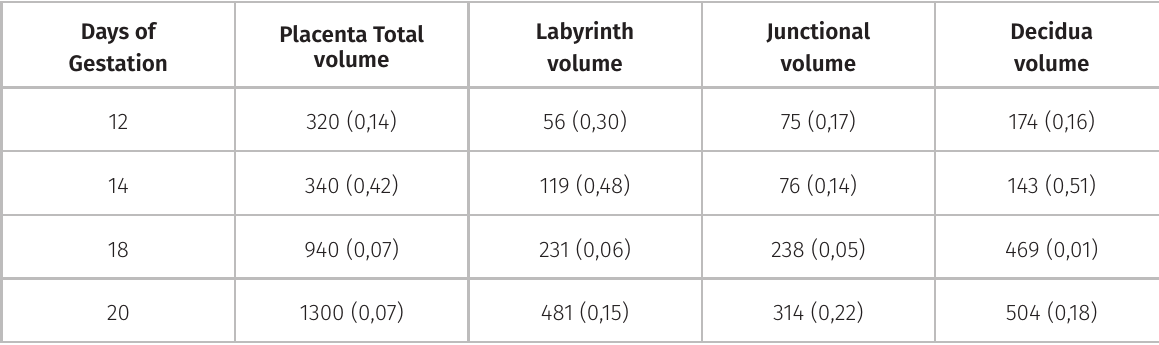
Table I. Mean value of total placental volume and placental compartments (mm 3 ) followed by coefficient of variation (CV) for 12 to 20 days of gestation in New Zealand